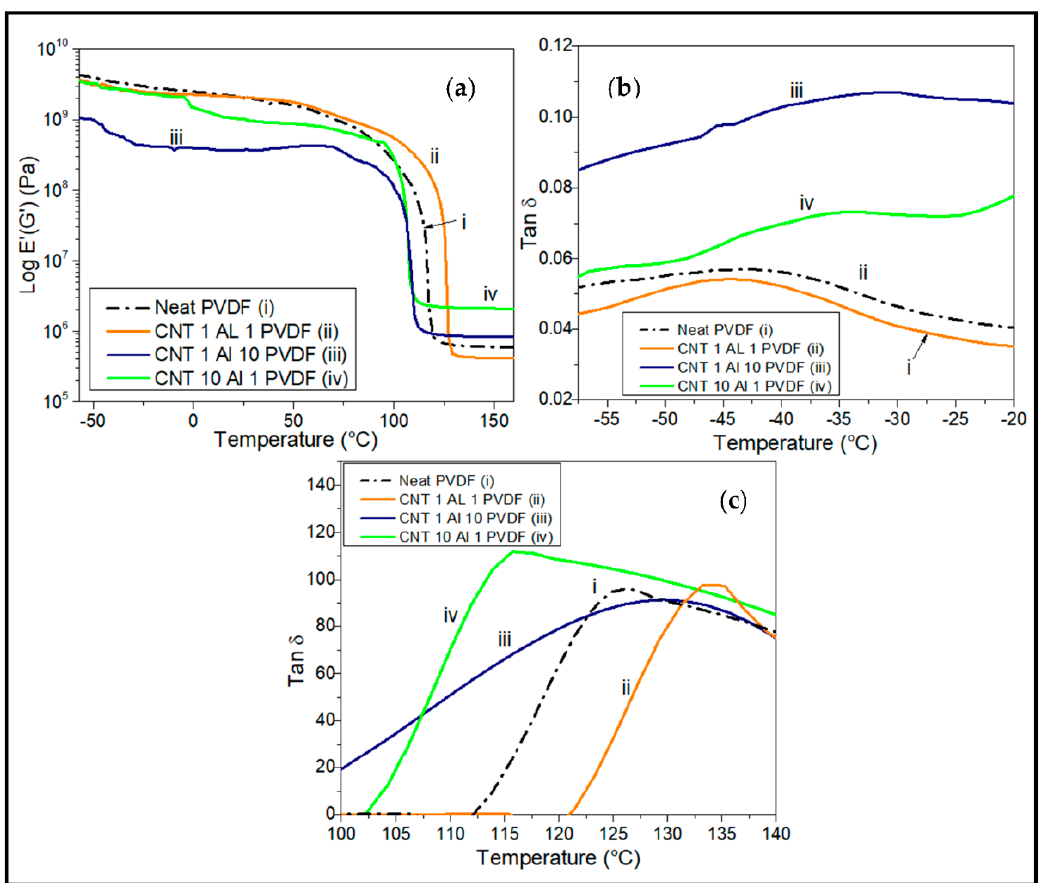
Figure 10. DMA plots comparing the ( a ) effect of combinatorial wt.% loading of CNT and alumina on the storage modulus of the PVDF nanocomposites at an oscillatory frequency of 1 Hz under tension. Tan delta peaks show ( b ) dynamic Tg between −55 °C and −20 °C, and ( c ) T m between 105 °C and 140 °C. Table 4. Summary of glass transition temperature (T g ) and melting temperature (T m ) measured us- ing DMA at 1 Hz.